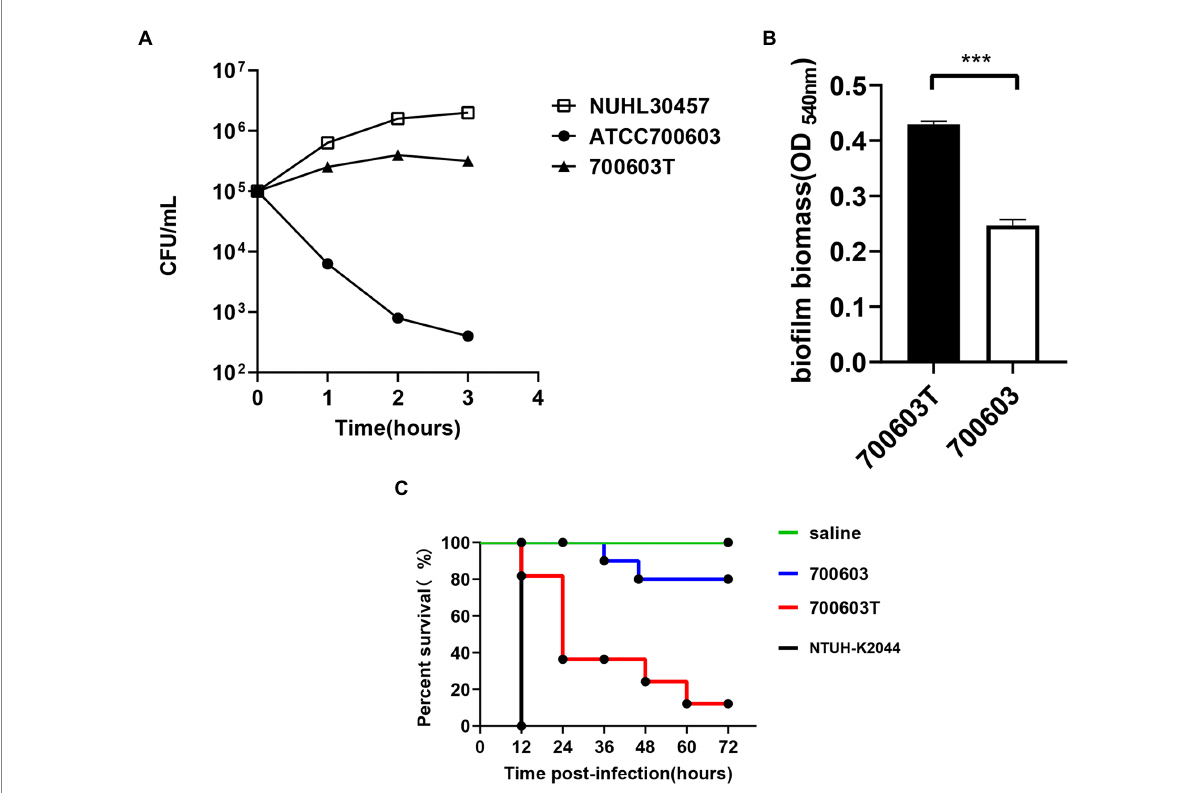
FIGURE 6 Virulence characteristics of transformants. (A) The serum resistance level of the 700,603 transformant strain. (B) The ability of the 700,603 transformant strain to form biofilm was evaluated by crystal violet assay. (C) The Mann–Whitney test was used for statistical analyses.***, p < 0.001. Virulence potential of the 700,603 transformant strain in a Galleria mellonella infection